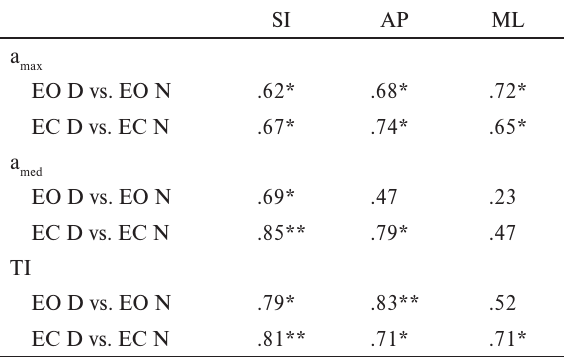
Spearman’s rank correlation coefficients between the data measured on dominant and on non-dominant upper